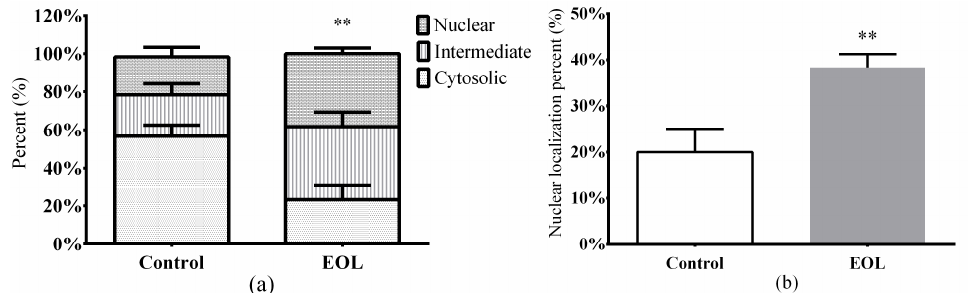
Figure 9. The effect of EOL on the transcriptional activity of daf-16 . ( a ) The subcellular location of daf-16 . ( b ) The daf-16 nuclear localization percent. Differences were considered significant at p < 0.01 (**).